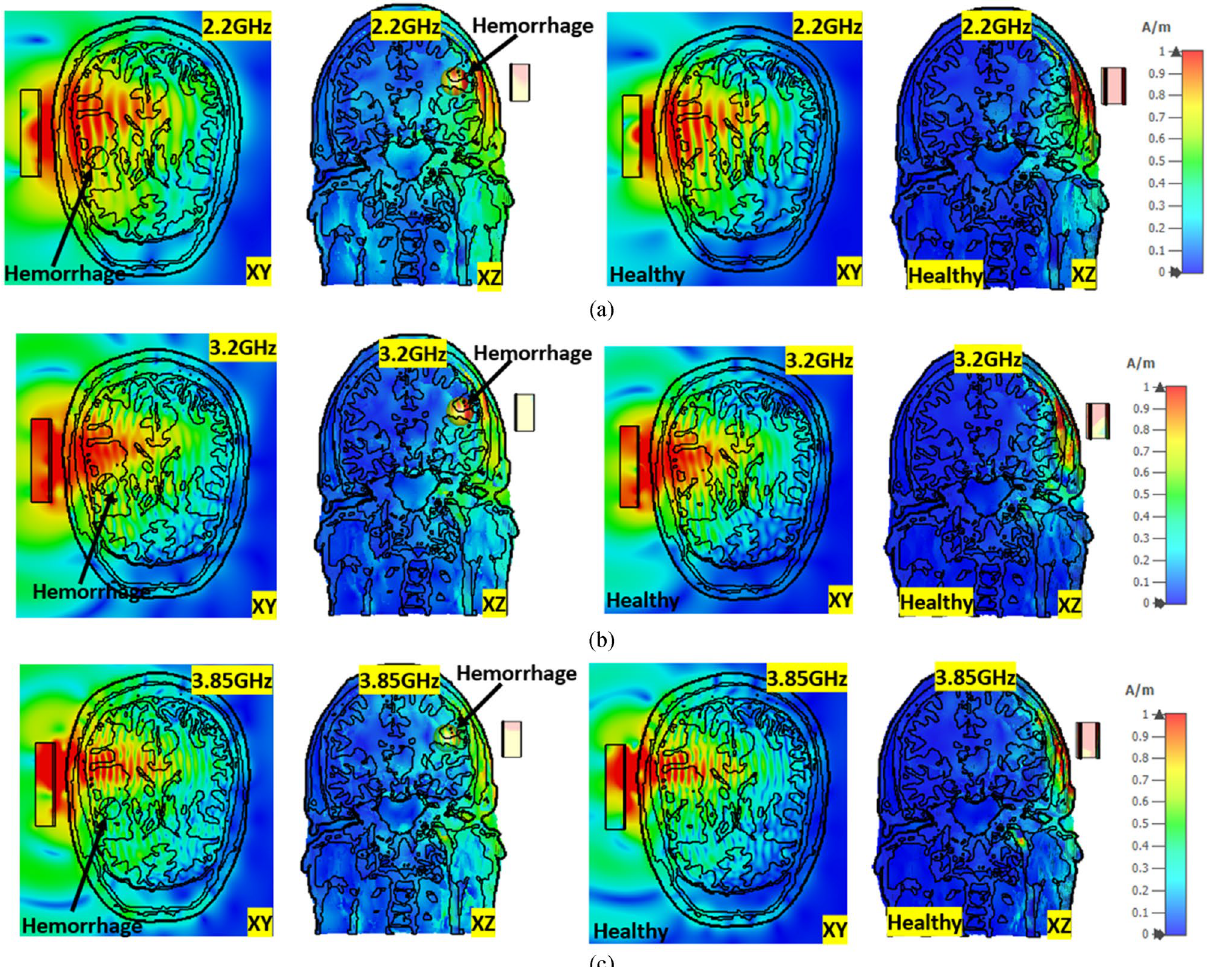
Figure 12. H-field distribution of healthy and unhealthy head at ( a ) 2.2 GHz, ( b ) 3.2 GHz, and ( c ) 3.85 GHz, respectively.